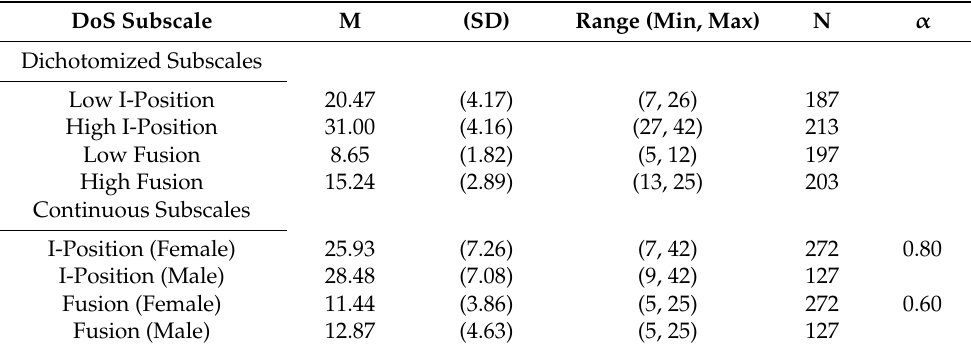
Table 1. Descriptive statistics and internal consistency of DoS